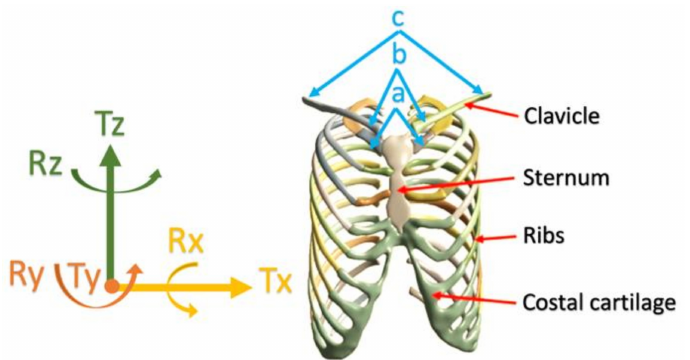
Figure 3. Redesigned representation of the load’s directions and locations of boundary conditions around the sternoclavicular joint